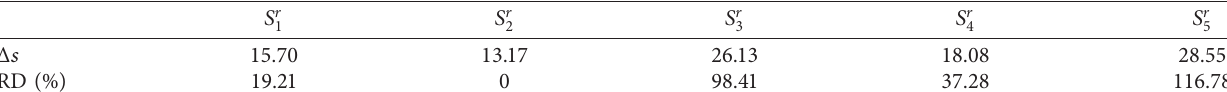
Figure 7: The operation starting time deviation for vessels with different weight coefficients. Table 5: The performances of robust berth plans based on different original plans.